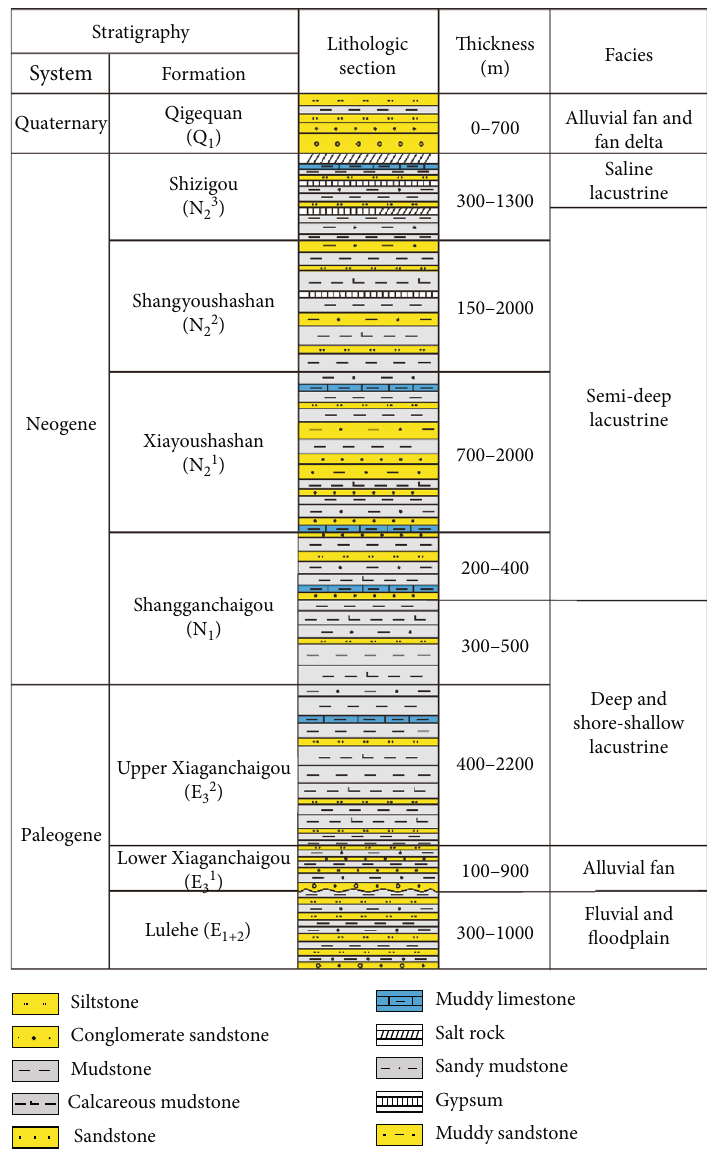
Figure 2: Generalized stratigraphic column for the western Qaidam Basin (modi fi ed after